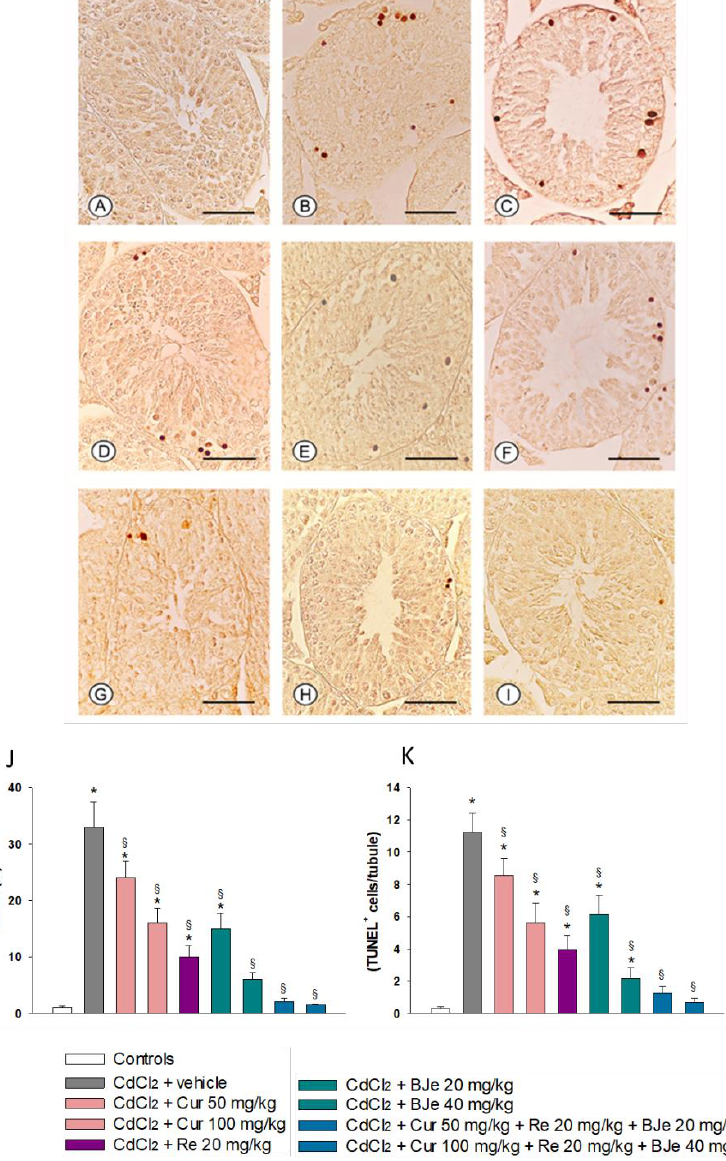
Figure 4. Assessment of apoptosis in mice testes with TUNEL staining technique (scale bar: 50 µm). ( A ): In control mice, no TUNEL-positive cells can be observed. ( B ): In the seminiferous